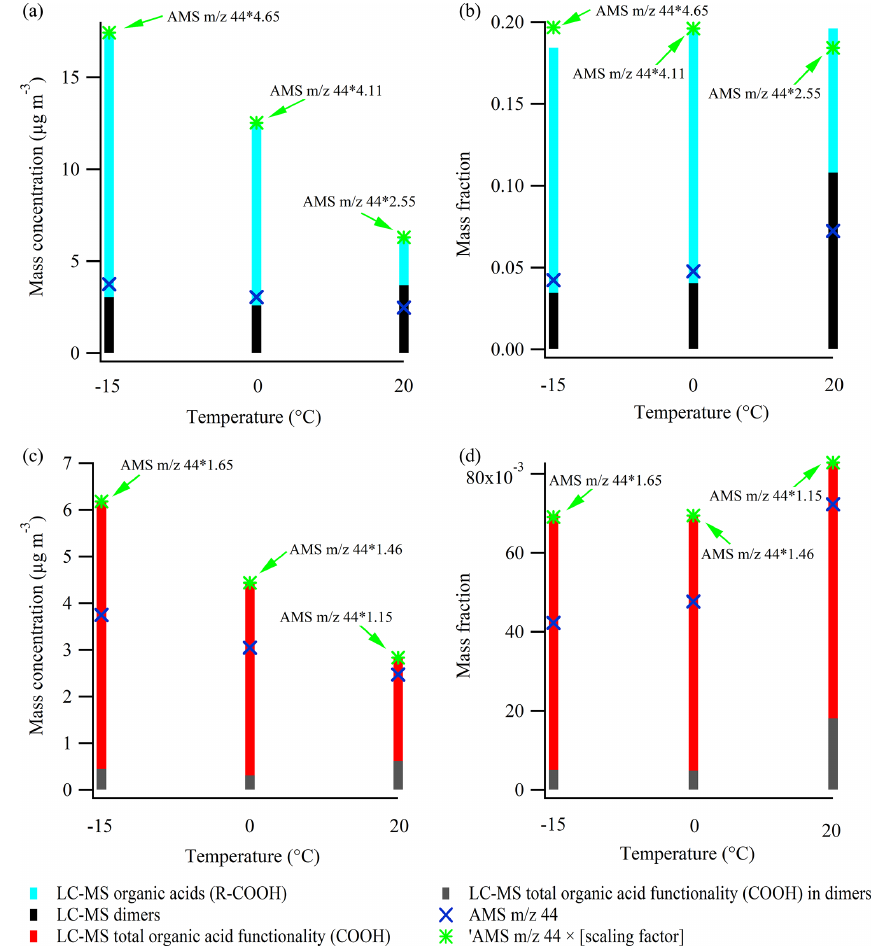
Figure 7. LC-MS-derived organic acid (R-COOH) mass concentration (a) and organic acid mass fraction (b) at − 15, 0, and 20 ◦ C. The organic acid functionality (-COOH) mass concentration and mass concentration at the three temperatures are shown in panels (c) and (d) , respectively. Additionally, the corresponding results related to dimers are shown. The panels also show m/z 44 – a tracer of organic acids – from the AMS mass spectra and the scaling factors to be applied to reach the level of organic acid (functionality) measured by the LC-MS. The particle filter samples analyzed by the LC-MS are obtained by the end of the experiments (see Table 1), whereas the AMS results are obtained right before the filter sampling (10min average). The figure is based on data from experiments